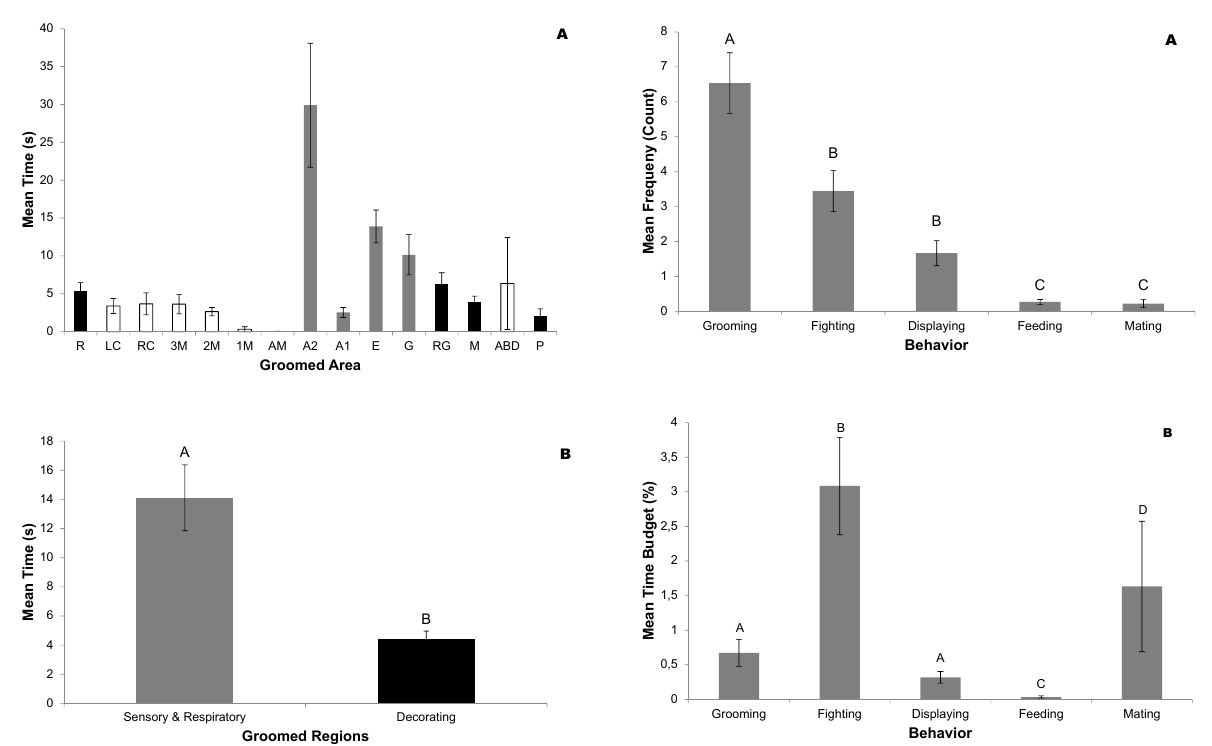
Figure 6. Mean time (s), with standard error bars, spent grooming body regions in 30-min isolation observations (N=142), A. Mean time grooming body regions (H=291, df=14, p<0.001), with x-axis organized by anterior body regions on the left to posterior body regions on the right. Sensory and respiratory structures were designated by gray bars: A1, A2, E, G; decoration body regions were designated by a black bars: R, RG, M, P. White bars are body regions not associated with sensory, respiratory, or decorations. bars) compared to body regions where decorations (black bars) are attached (N=598, t=9.48, p<0.001). A1, first antennae; A2, second antennae; ABD, abdomen; AM, all maxillipeds; E, eye; G, gills; M, dorsal mid-carapace; LC, left P1 cheliped; M1, first maxilliped; M2, second maxilliped; 3M, third maxilliped; P, pereiopods 2–5 (walking legs); R, rostrum; RC, right P1 cheliped; RG, lateral ridge. Note: Similar letters indicate no statistical significance (p>0.05) and different letters indicate a statistical significance (p<0.05).